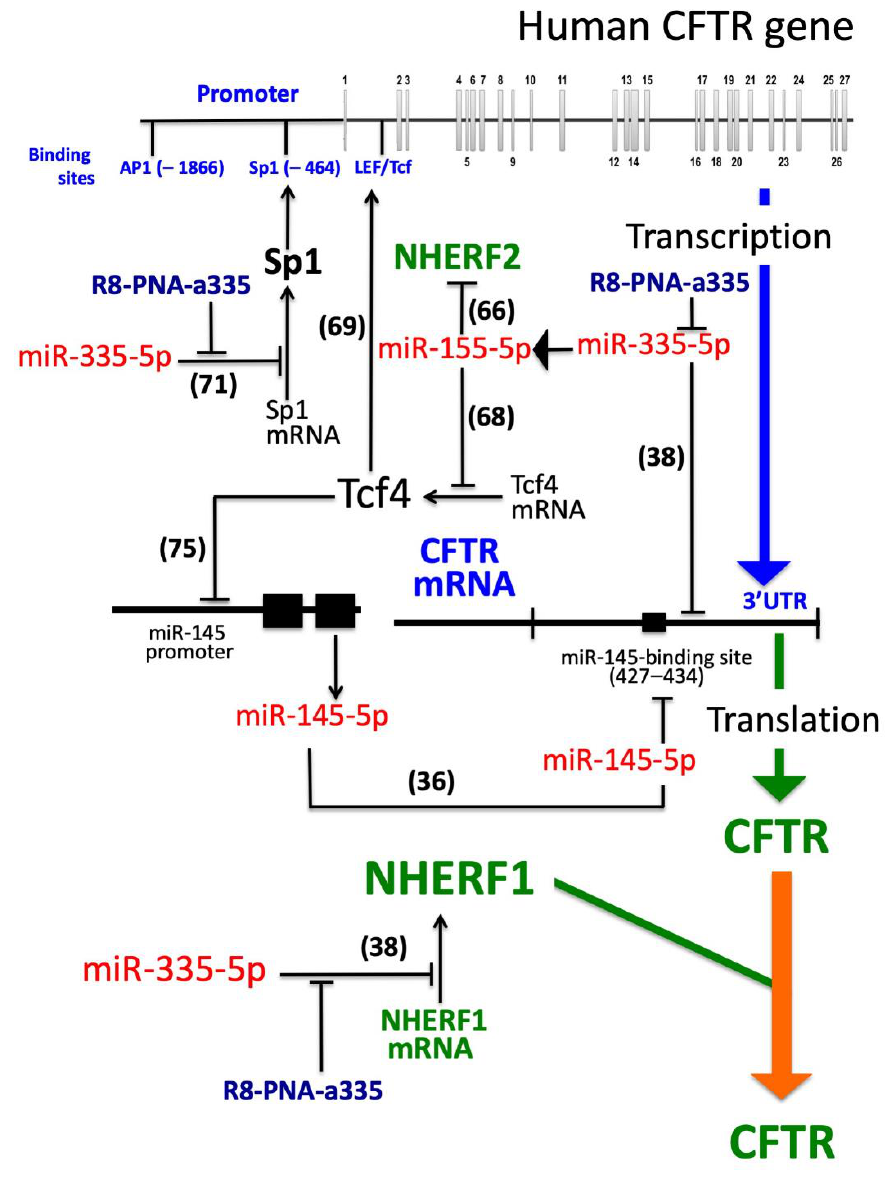
Figure 8. Proposed model for the interplay between transcription factors, NHERF1, CFTR regulation and miR-335-5p regulated molecules. The published information concerning specific steps are indicated in parenthesis. The effects of R8-PNA-a335 on miR-335-5p are presented in Figure 3. The effects of R8-PNA-a335 on miR-155-5p are described in Figure 7. The effects of R8-PNA-a335 on NHERF1 and CFTR are presented in Figure 4. MicroRNAs and PNAs are in red- and blue-marked, respectively. The colored arrows represent transcription (blue), translation (green) and processing (orange).